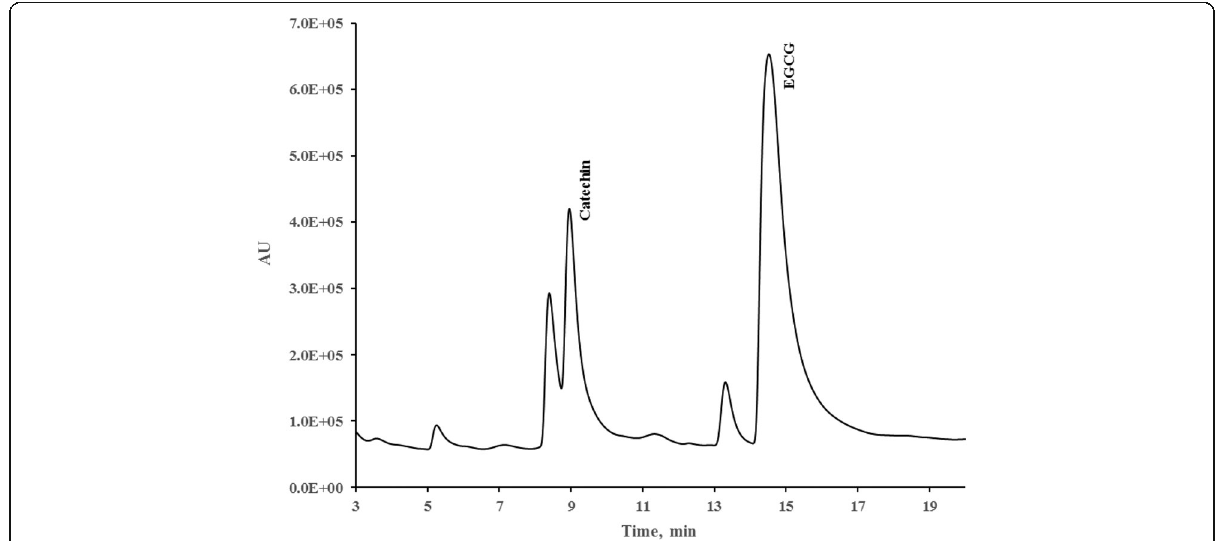
Fig. 3 Spiking experiment and identification of catechin and EGCG in tea extract matrix using phenyl-hexyl core-shell column